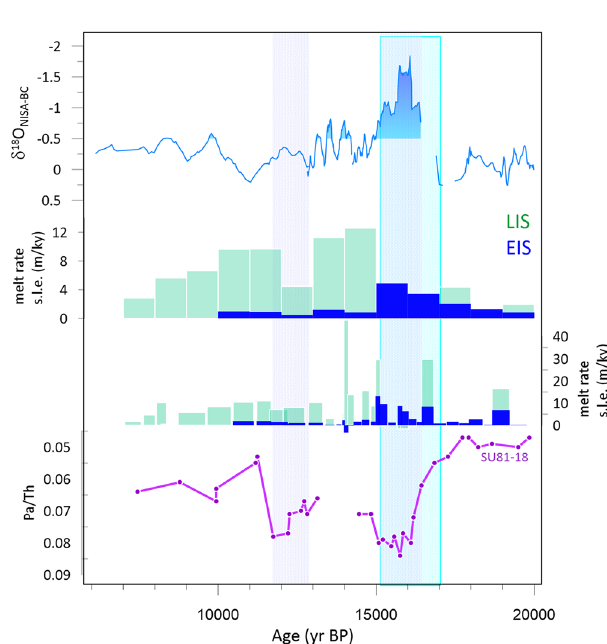
Fig. 7 Time series of regional δ 18 O sw anomaly over TI vs NH melting rate and AMOC indicators. Regional freshwater anomaly δ 18 O NISA-BC compared with estimations of the melting rate NAIS and EIS, from 41 (20 to 12 ka) and from 34 (6 – 12 ka). Shown are melt rates derived from sea level curves interpolated to uniform 1 ky resolution, to facilitate comparison to TII available only at this resolution (Fig. 3), as well as rates at original published resolution. Also shown is the Pa/Th indicator of AMOC intensity 50